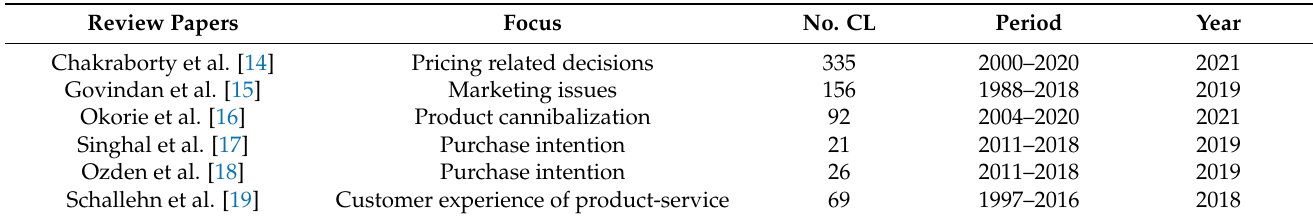
Table 1. Researching the status quo of review papers related to remanufacturing trade. Focus No.